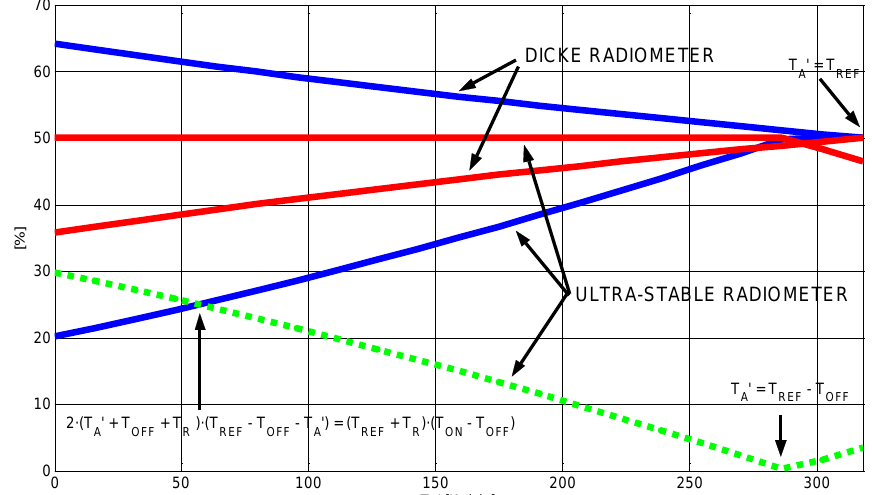
Figure 3. Fractions of integration time spent in the antenna (solid blue lines), antenna + noise (dotted green line) or reference (solid red lines) for the ultra-stable and Dicke radiometers with duty-cycle modulation. For the ultra-stable radiometer a slope change occurs at T = T - T . Note that the cross point depends on T for the ultra-stable A REF OFF R radiometer (among several other parameters). For the Dicke radiometer with duty-cycle modulations the cross-point occurs at T = T . A REF Fraction of integration time measuring the antenna (blue solid lines), antenna plus noise (green dotted line), and reference (red solid